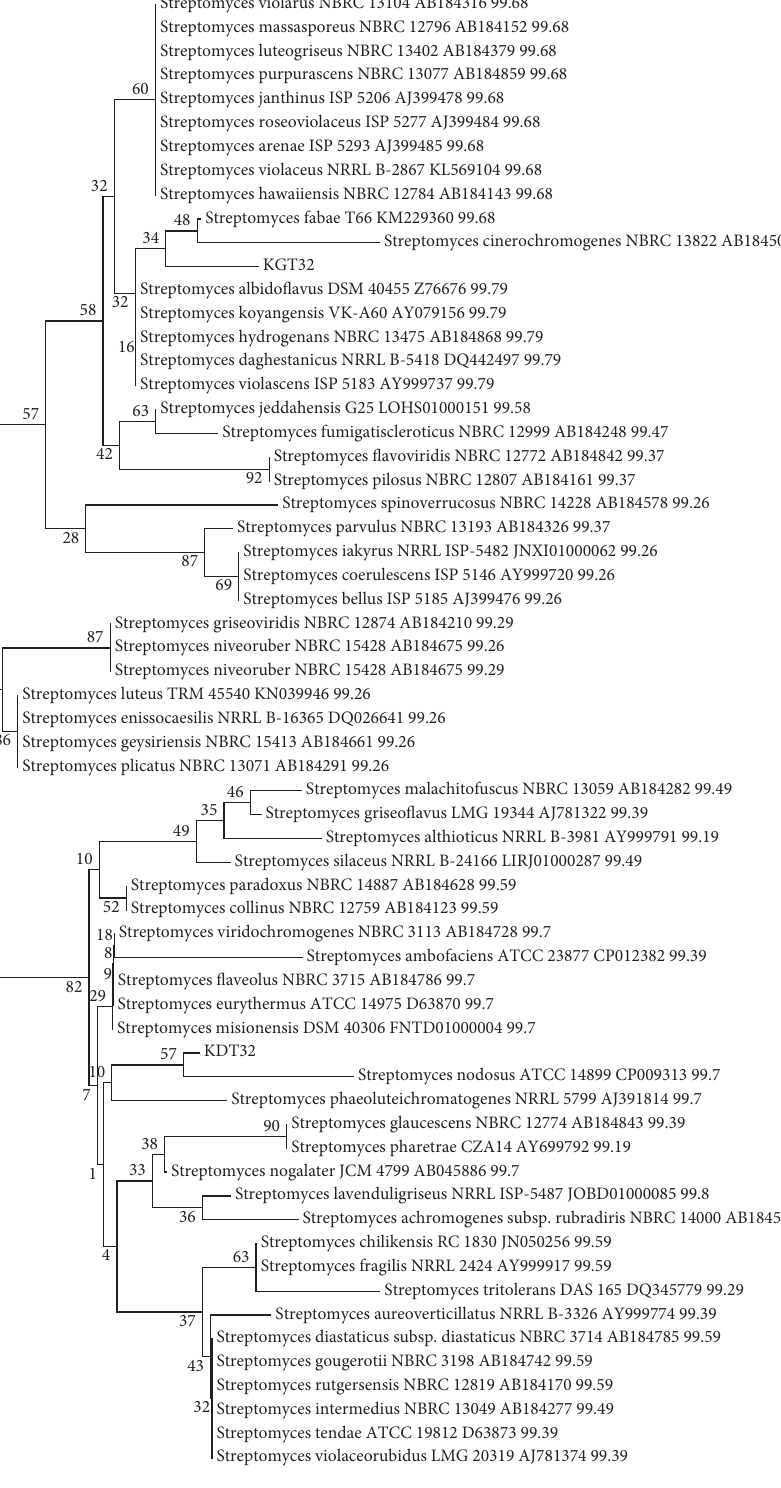
Figure 13: Taxonomic position and evolutionary relationship determination of KDT32 and KGT32 isolate sequences with reference sequences (strains of genus Streptomyces ) from phylogenetic tree constructed by ML algorithm. The phylogenetic tree was validated by a bootstrap analysis (1000 replications) with values shown at branch nodes. Bar indicates substitutions per nucleotide position. Evolutionary analyses were conducted in MEGA7. Streptomyces violarus NBRC 13104 AB184316 99.68: Streptomyces violarus � taxon name; NBRC 13104 � strain type; AB184316 � GenBank accession number; 99.68 � percent of sequence